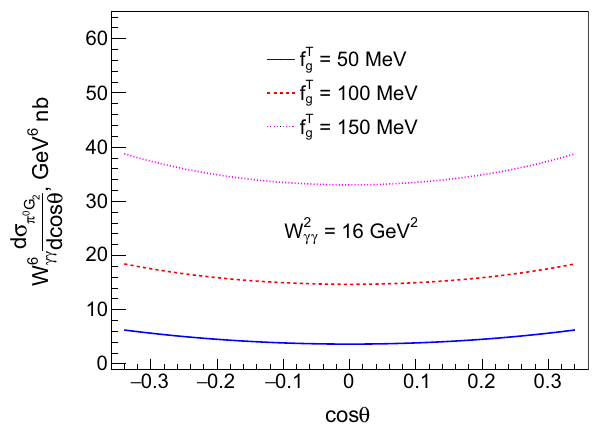
Fig. 2 The example of cross section as a function of cos θ at W 2 γγ = 16 GeV 2 . The solid, dashed and dotted lines correspond to f T g = 50 MeV, 100 MeV and 150 MeV [31]